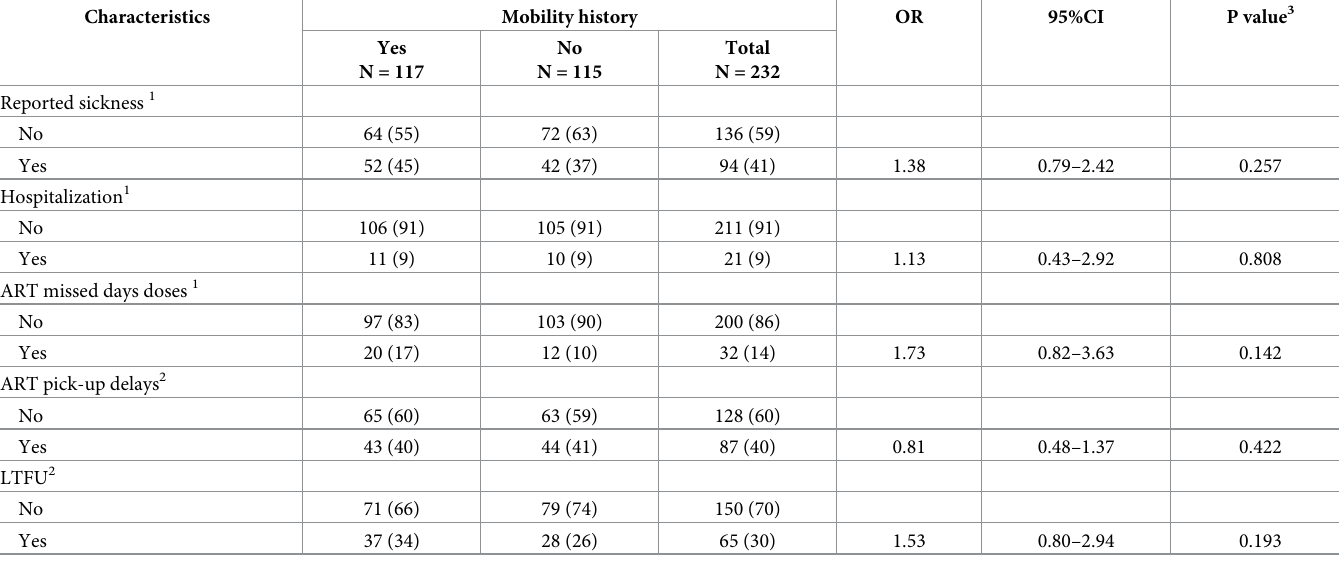
Table 3. Impacts of caregiver´s mobility on child´s health and HIV care during the mobility events period.